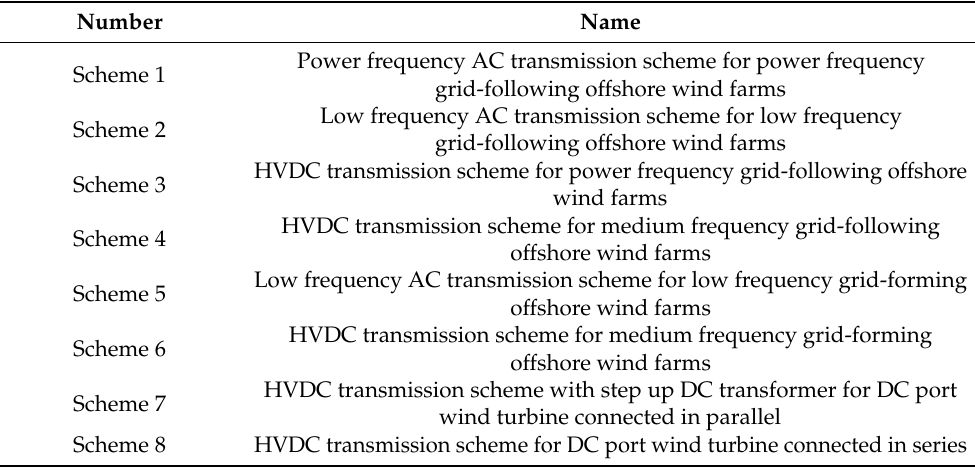
Table 1. Summary of eight typical schemes.